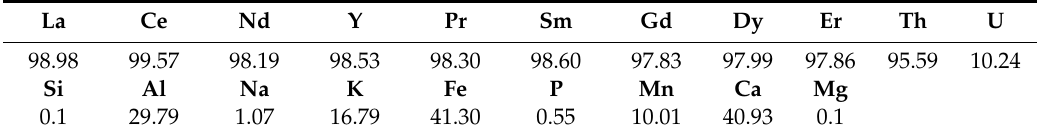
Table 7. Precipitation e ffi ciency (%).